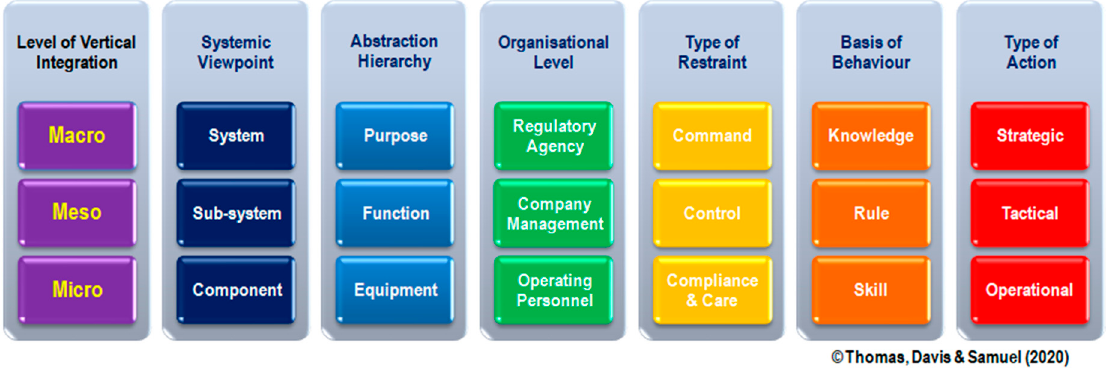
Figure 7. Macro, Meso and Micro Levels of Vertical Integration in Different Contexts.